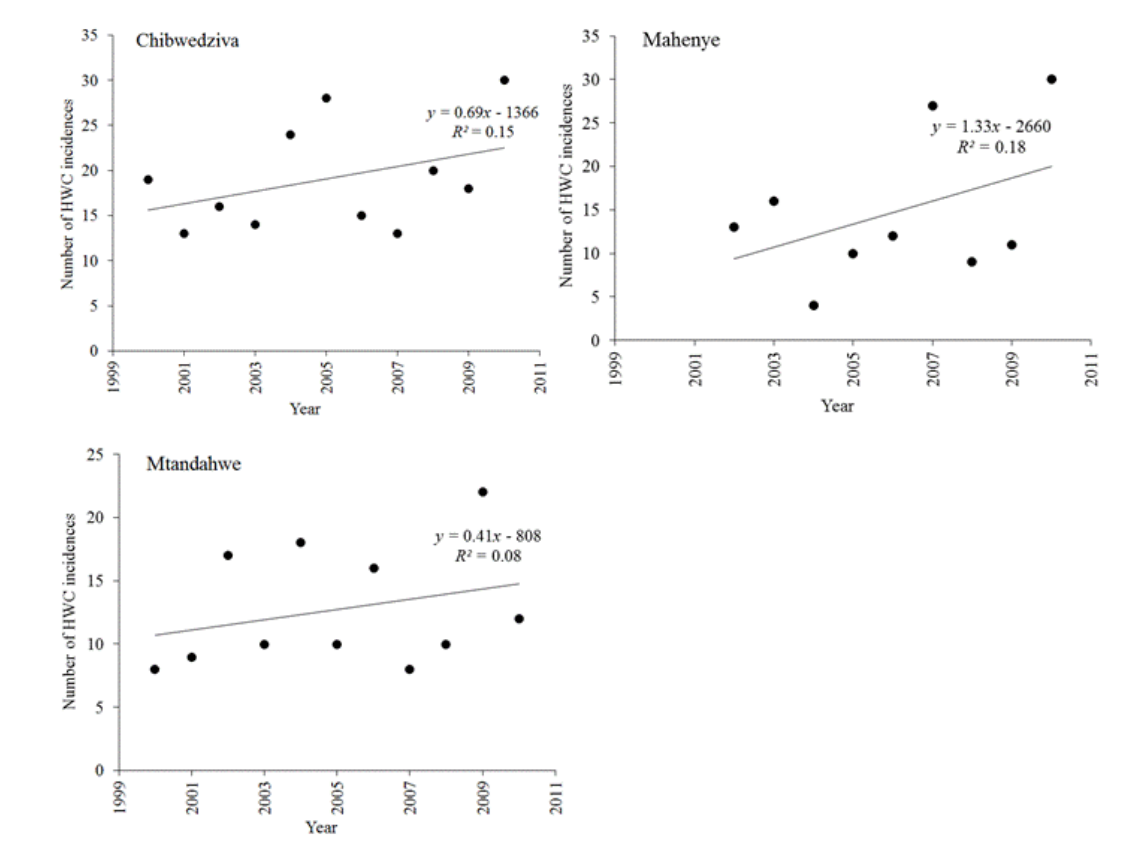
Fig. 2 . Trends in recorded human-wildlife conflict (HWC) incidences in communities adjacent to the northern Gonarezhou National Park, Zimbabwe between 2000 and 2010. Human-wildlife conflict incidences data for Chizvirizvi were